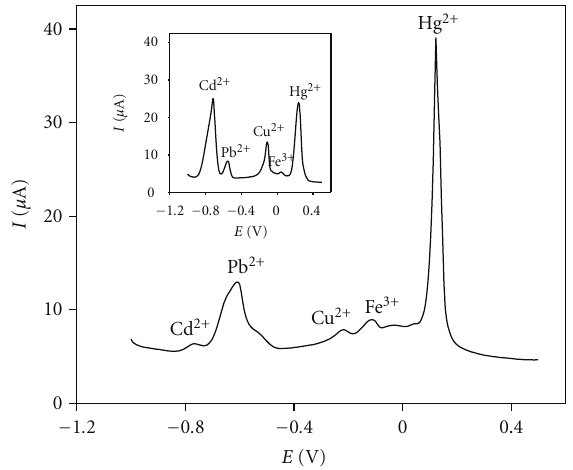
Figure 5: DPVs of 1 µ molL − 1 Hg 2+ in the presence of 10 µ molL − 1 each of Cd 2+ , Pb 2+ , Cu 2+ , Fe 3+ , Zn 2+ ions at AAP-modified GCE. The other conditions are those in Figure 4. Inset figure: DPVs of the same electrolyte on bare